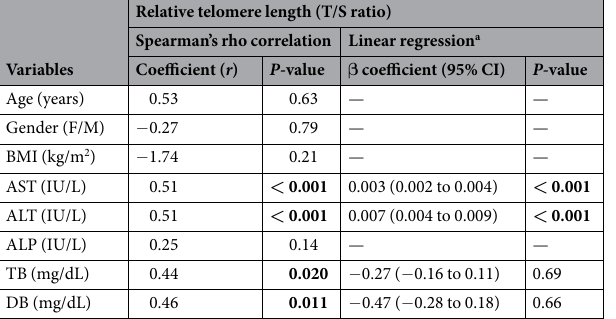
Table 3. Spearman’s rho correlation and multivariate linear regression analyses of RTL estimates. Adjusted for age, gender, BMI, drinking status, and smoking status. Abbreviations: ALP, alkaline phosphatase; ALT, alanine